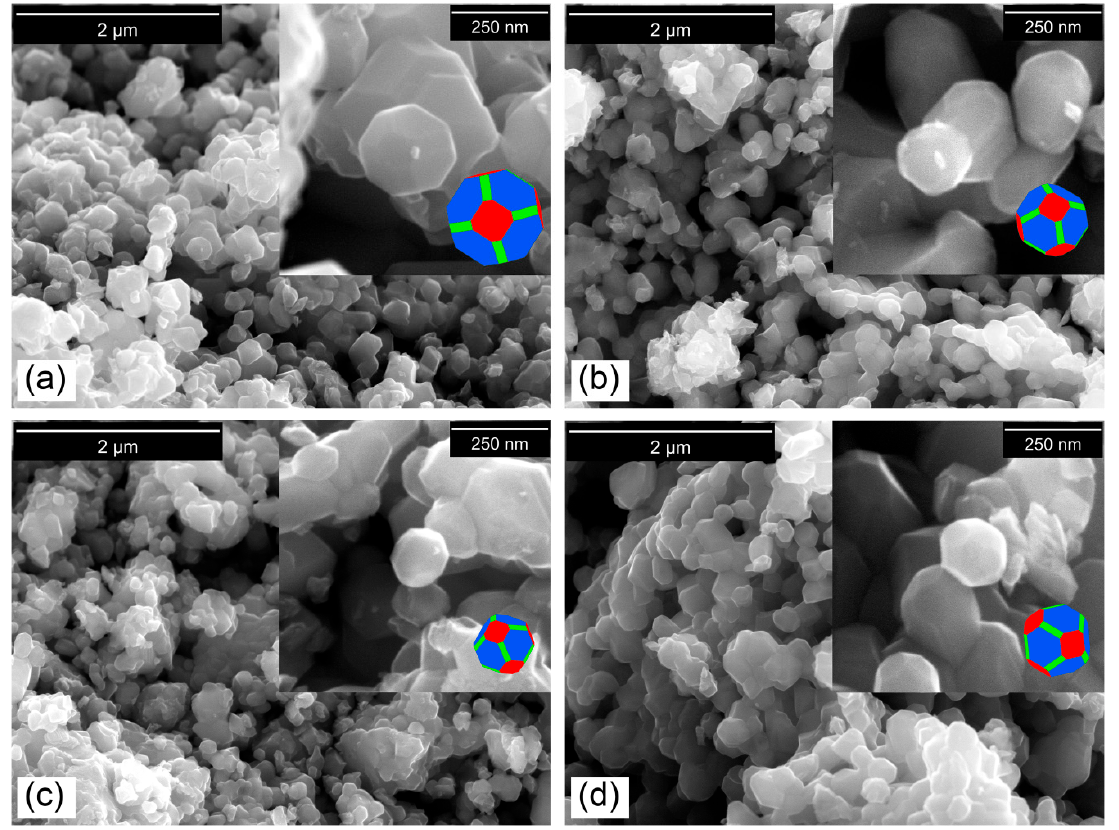
Figure 8. FE-SEM images of the nanometric powders of magnesium-doped manganese spinels: ( a ) LMO, ( b ) LMOMg-1, ( c ) LMOMg-2, and ( d ) LMOMg-3. Insets show truncated octahedral-type morphology of primary particles that make up spinel powders. The (111) planes in blue, (100) planes in red, and (110) planes in green.